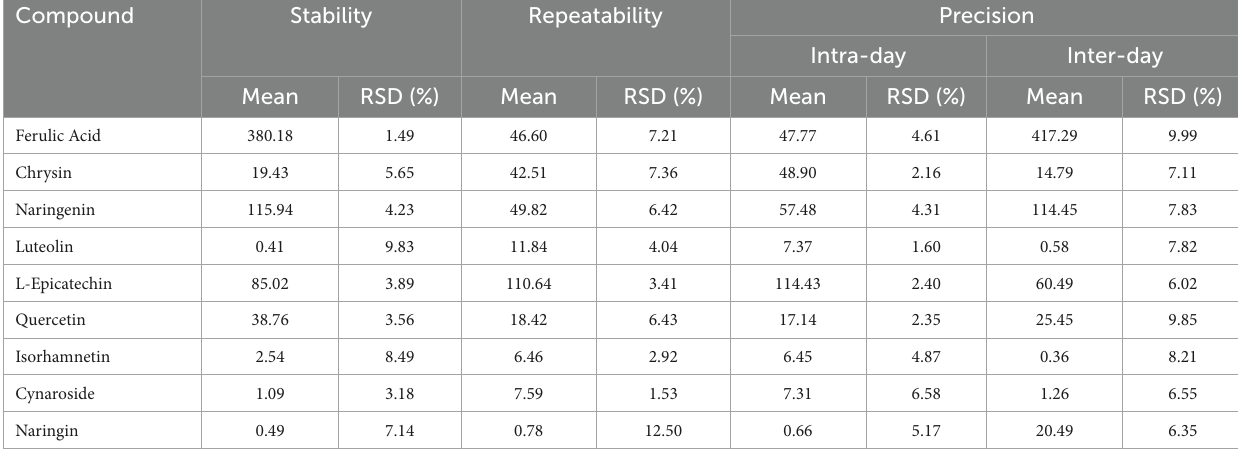
TABLE 3 Stability, repeatability, inter-day precision, and intra-day precision of nine